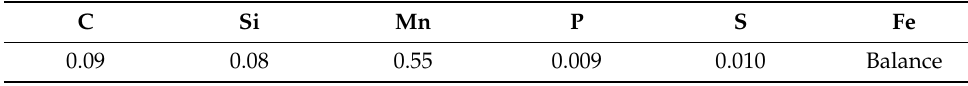
Table 1. Chemical composition of low-carbon steel.